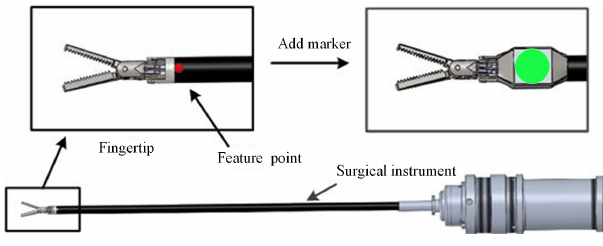
Figure 3. Surgical instrument marker